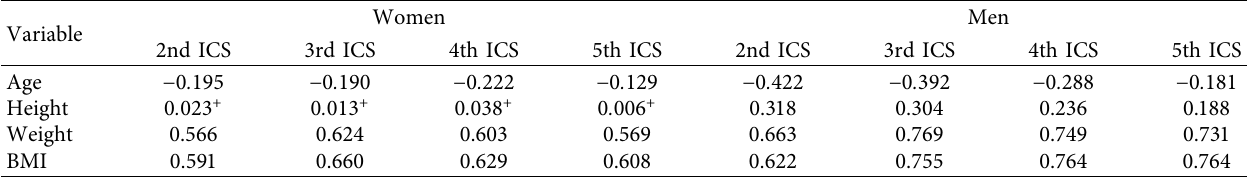
Table 2: Correlation coefficients between variables and ICSs.